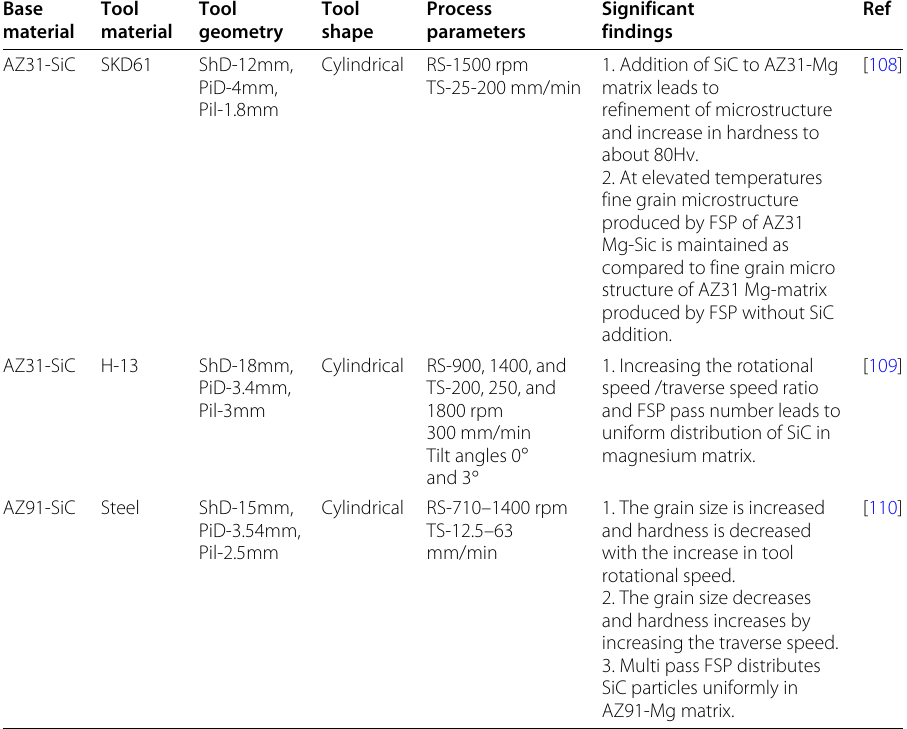
Table 4 Brief summary of Mg-MC surface MMCs by FSP as available in the